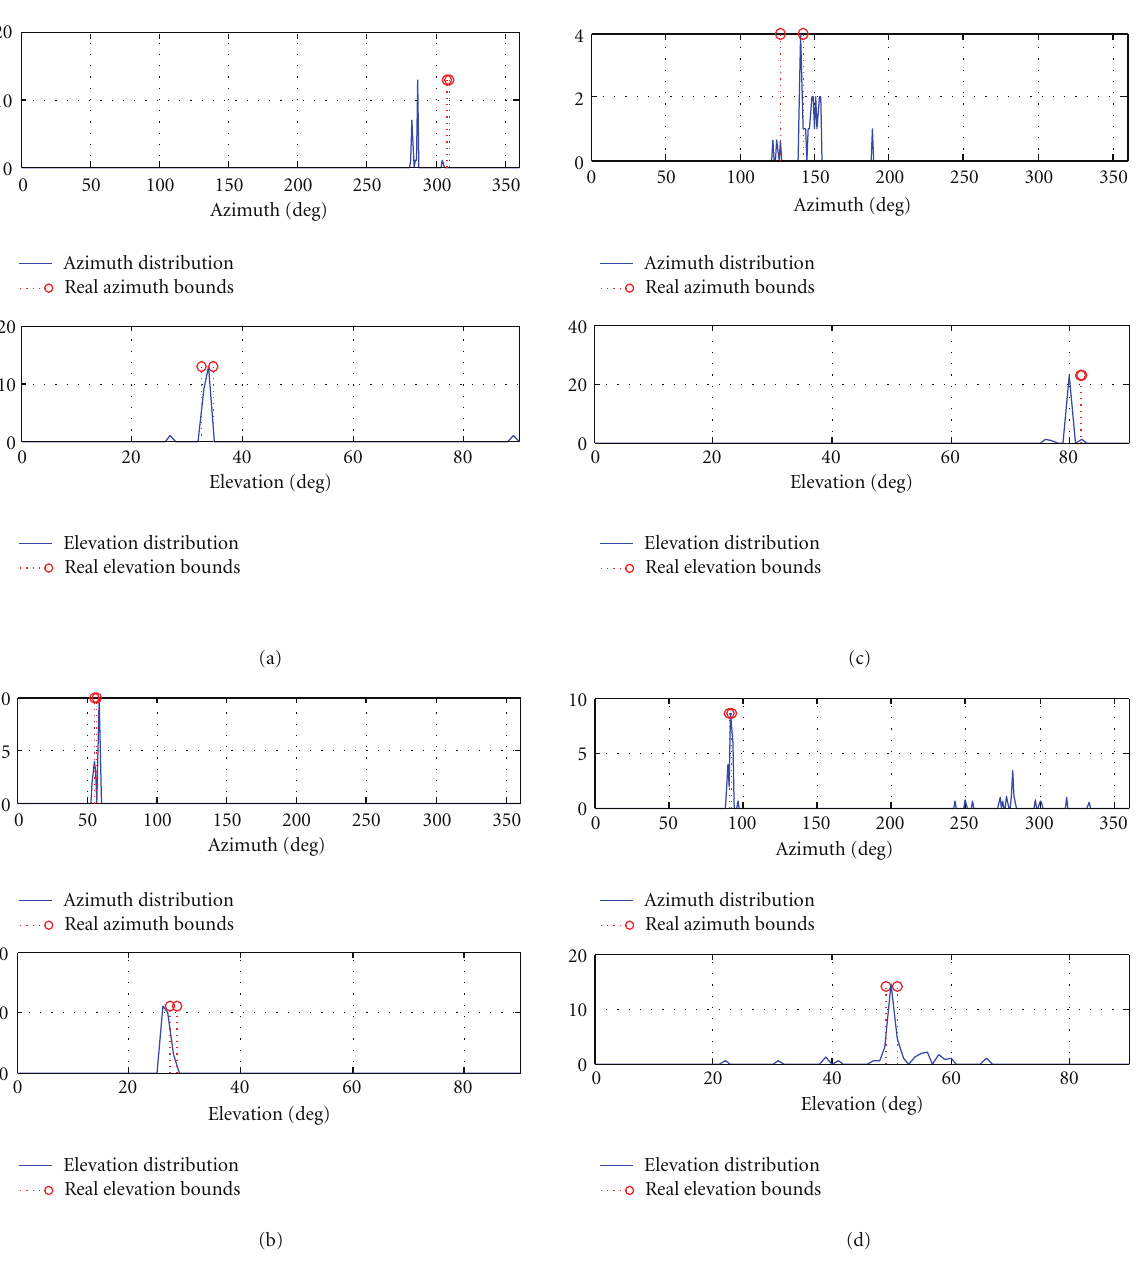
the satellite, but solely on the rotation rate of the lever